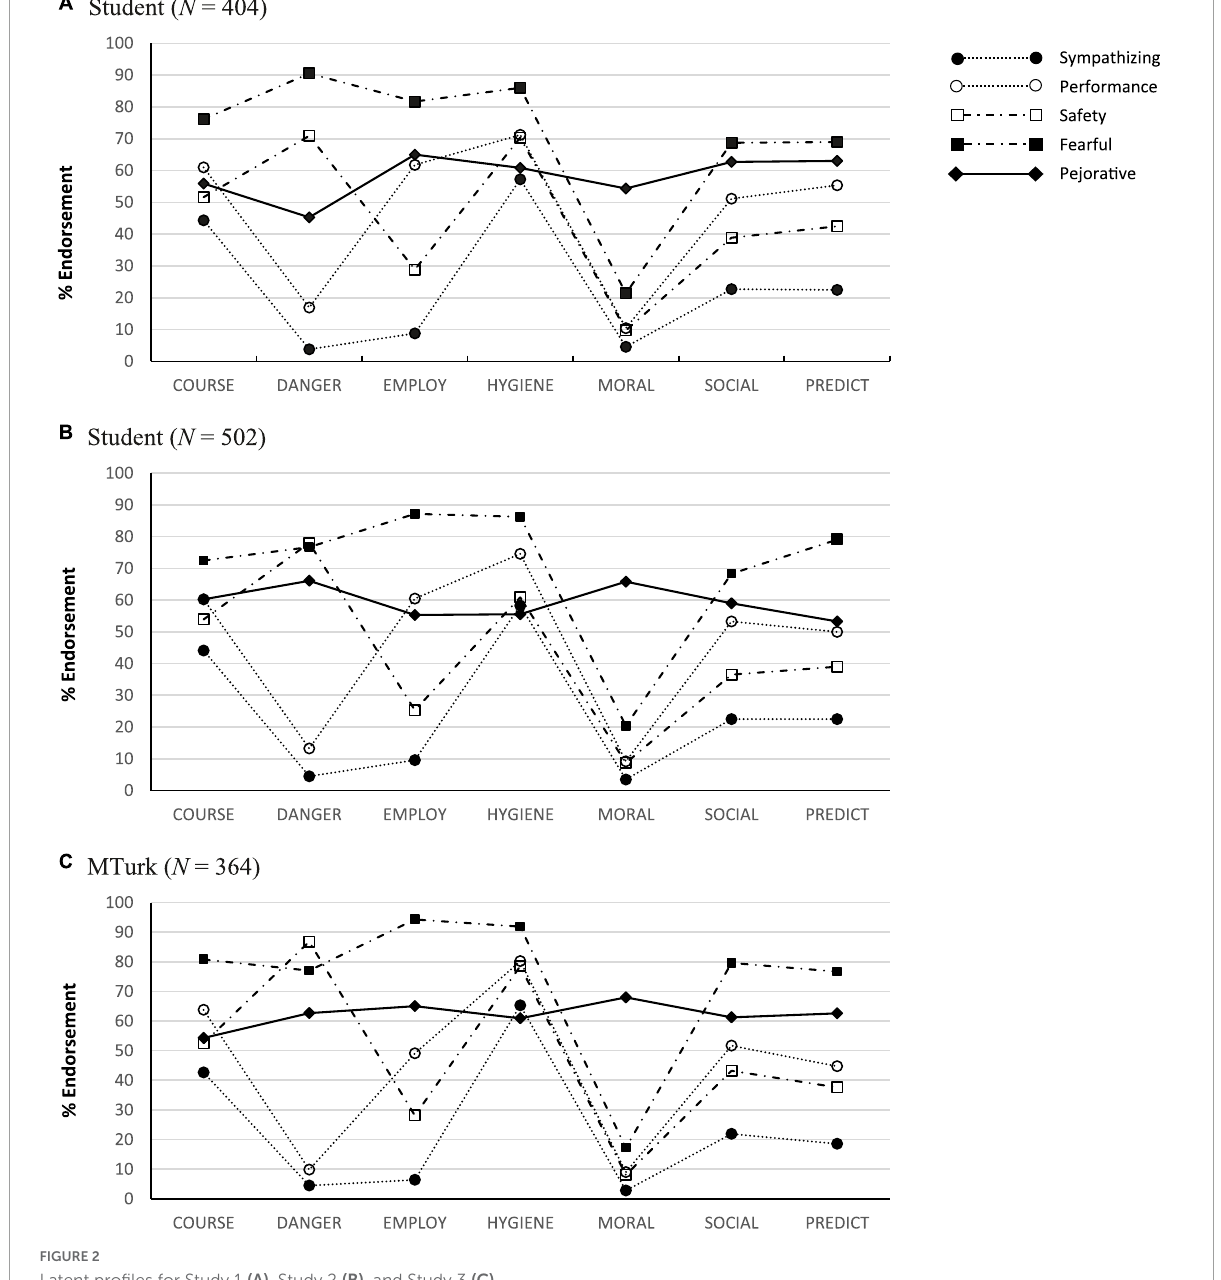
FIGURE2 Latent profiles for Study 1 (A) , Study 2 (B) , and Study 3 (C)